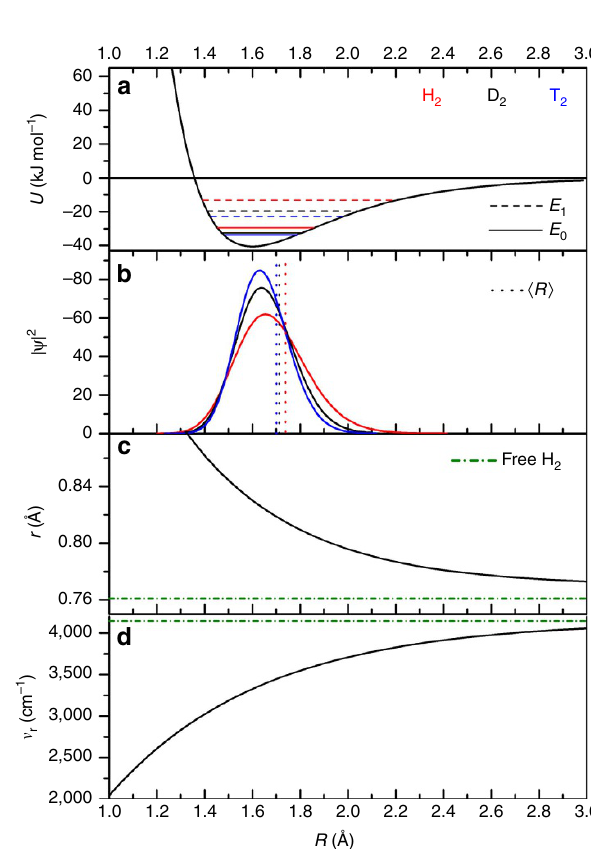
Figure 4 | Properties of adsorbed molecular hydrogen at the Cu(I) sites. ( a ) The interaction potential U of H 2 as function of distance R of the molecular centre of H 2 from the Cu(I) site. The curve fits to a Morse potential, and the vibrational energy levels E 0 (zero point energy) and E 1 (first excitation) are given for the adsorbed hydrogen isotopologues H 2 (red), D 2 (black) and T 2 (blue). ( b ) Probability density C R ð Þj j 2 of the adsorbed hydrogen isotopologues (same colour code). Probability values are given as dotted vertical lines. ( c ) Intramolecular H 2 distance r as function of R . ( d ) Frequency of the vibrational intramolecular stretching mode n r of the adsorbed isotopologues. In c , d , the value for free H 2 (green dash-dotted line) are given for